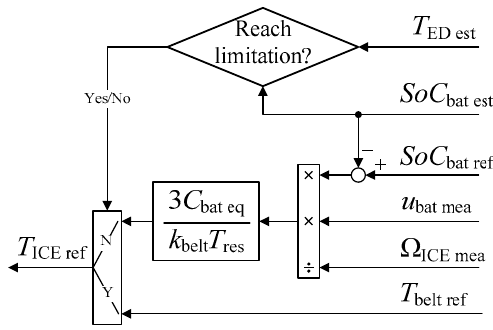
Figure 5. Implementation of the proposed LQR-based EMS.